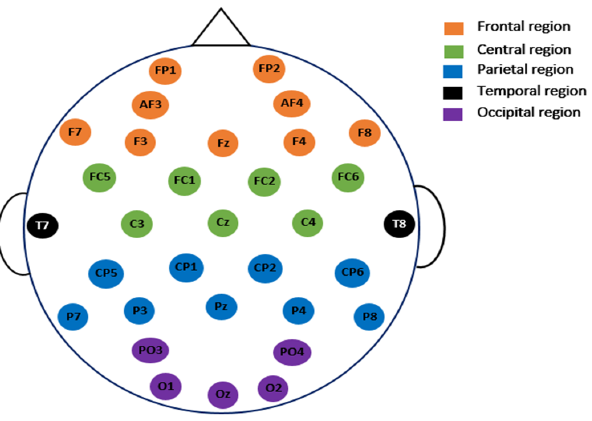
Figure 2. The placement of the electrodes for the 32 EEG channels used in SanDiego dataset.